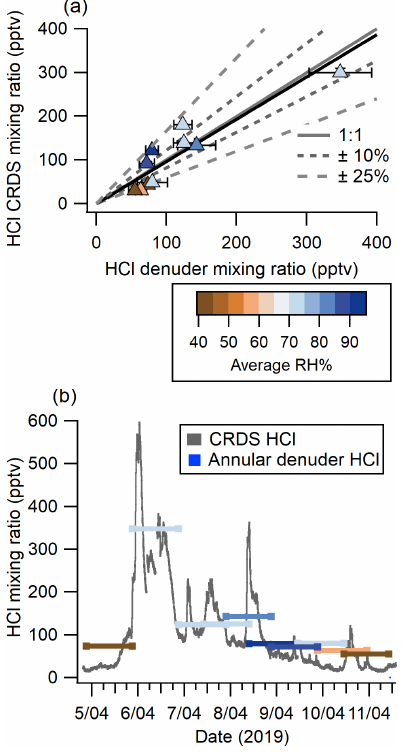
Figure 3. (a) Comparison of HCl measured from 4–11 April 2019 using annular denuders and CRDS (averaged to the collection time of denuders). Denuder error bars are derived from the error in the IC calibration, standard deviation of method blanks, and extraction recovery. CRDS measurement errors are the precision in a single measurement combined with data loss for flagged instrument er- rors. Also shown are a 1:1 correlation line (solid grey), 10% (short grey dash) and 25% (long grey dash) deviation from 1:1, and the orthogonal distance regression (solid black). Points are coloured by the average RH during sampling. (b) Continuous HCl mixing ratio time series by CRDS overlaid with averaged 24h denuder measure- ment analyzed by IC with lines coloured according to the average RH during